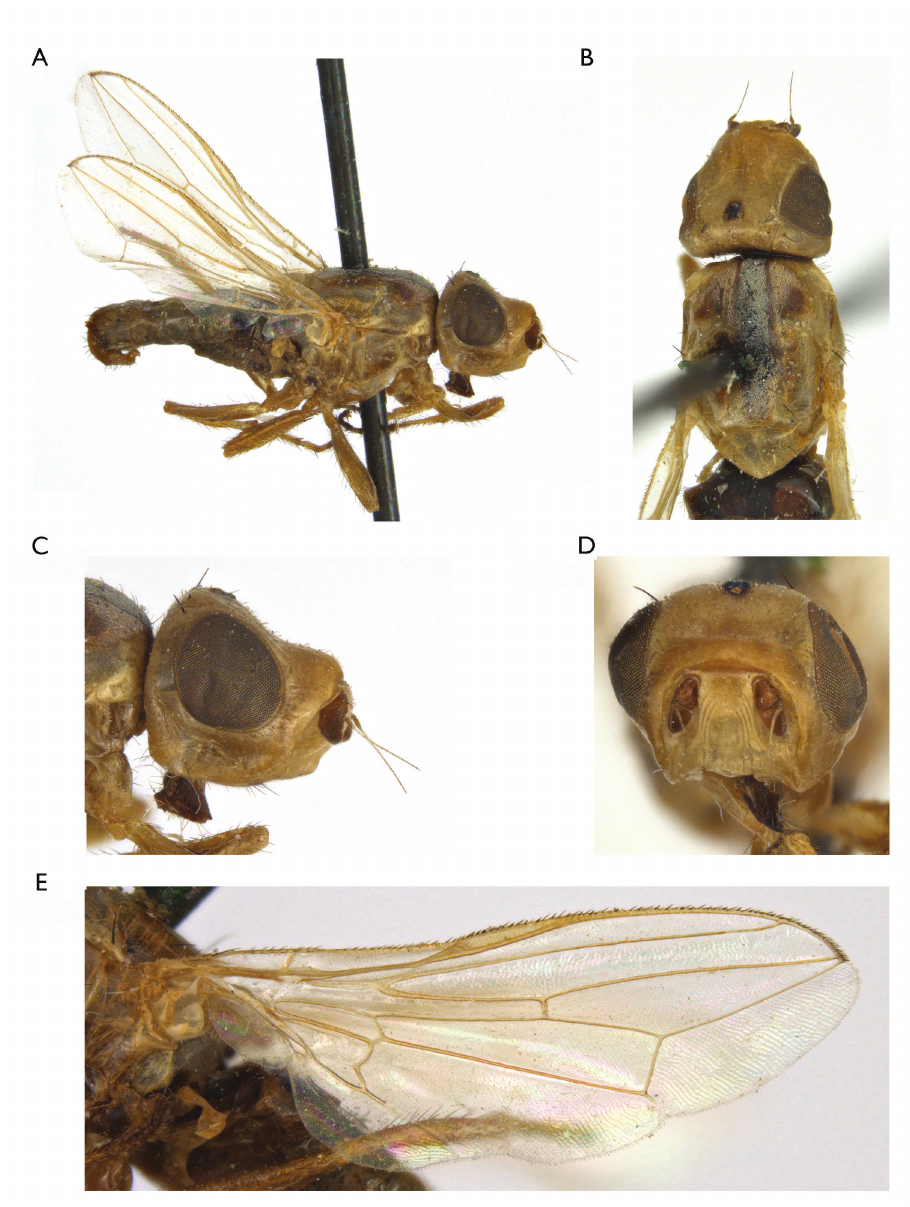
Figure 5. Timia canaliculata Becker, 1906, lectotype male A habitus, lateral view B head and thorax, dorsal view C head, lateral view D head, anterior view E